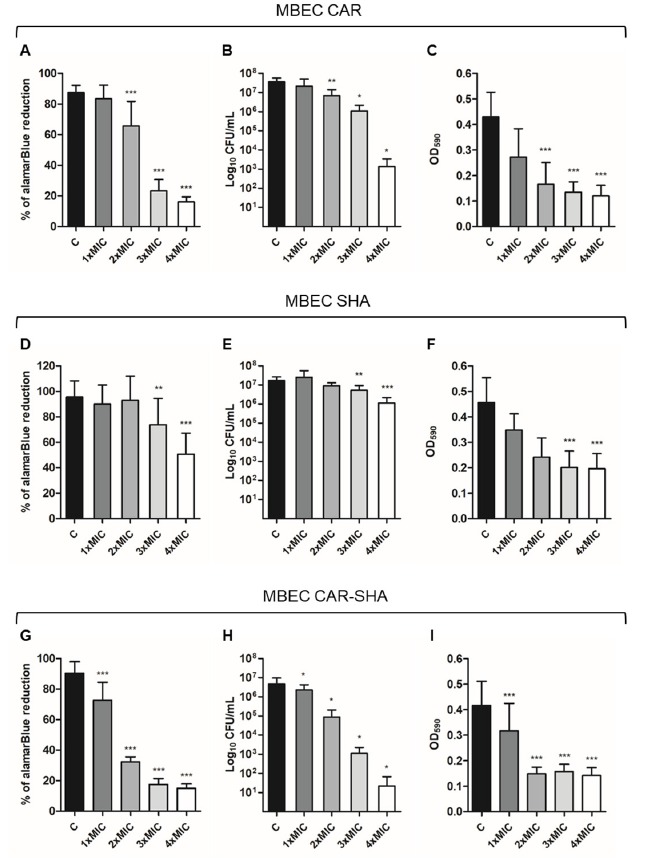
Figure 3. In vitro activity of CAR and SHA alone and in combination against H. pylori